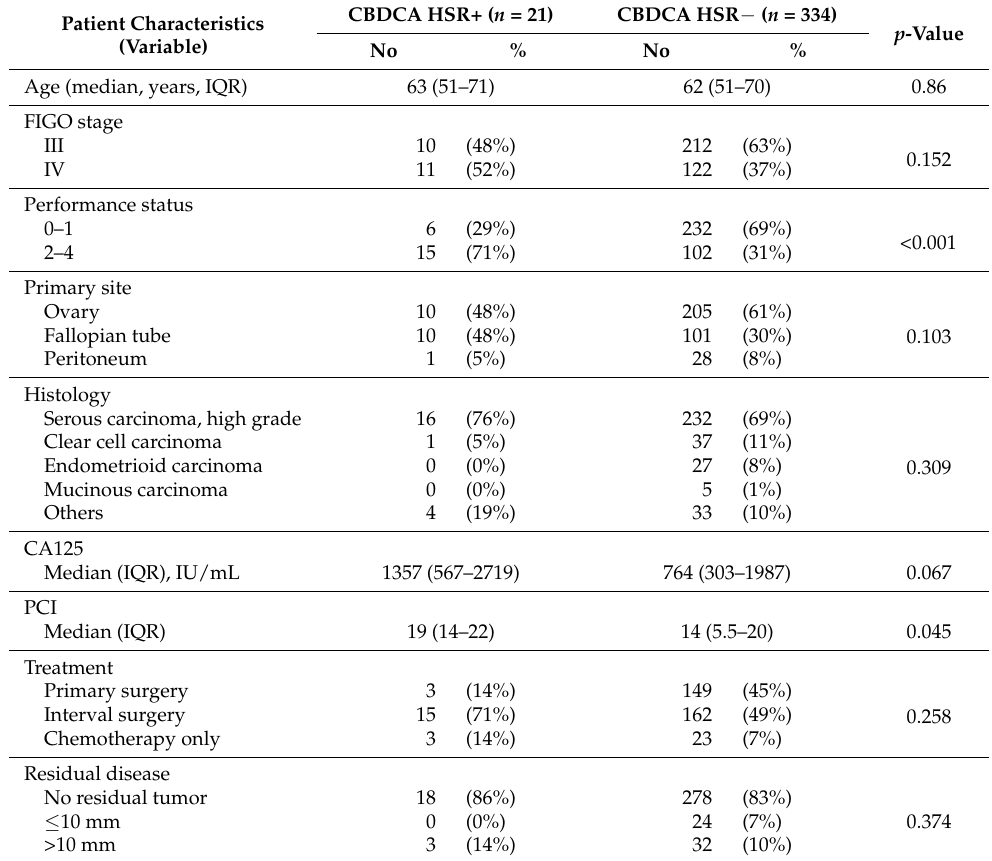
Table A1. Comparison of characteristics between patients with carboplatin hypersensitivity reaction or not.